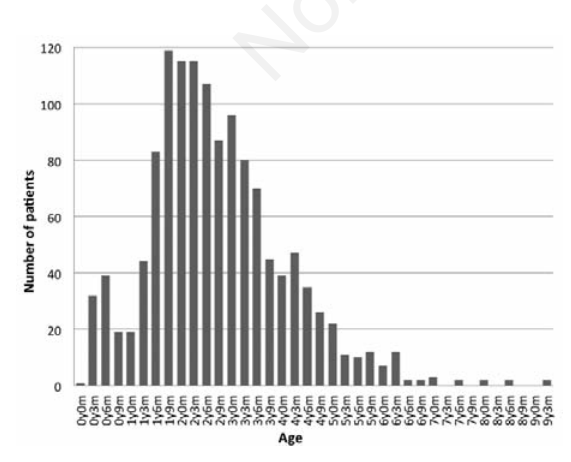
Figure 4. Mechanism of injury and number of patients: less than 1-year-old group/ 1-year-old or older group. P<0.008 The significance on c 2 analysis with Bonferroni correc- tion was defined as